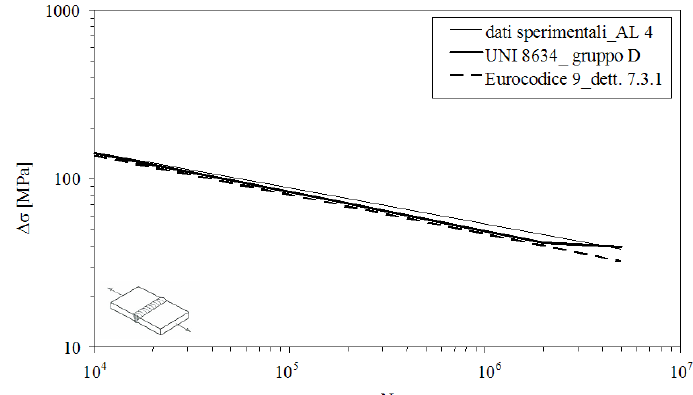
Figura 8: Confronto tra curva di resistenza a fatica per giunti testa a testa.